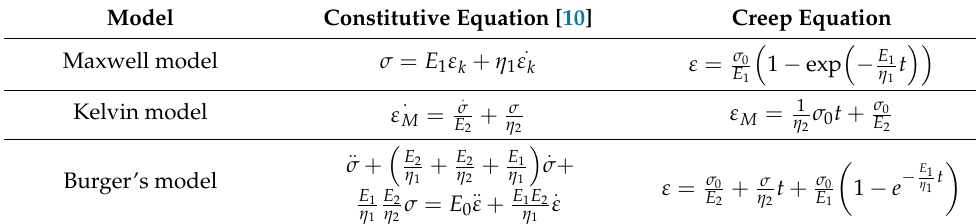
Figure 3. Burger’s model in DEM contact. Table 1. The equations of Burger’s model and its components.